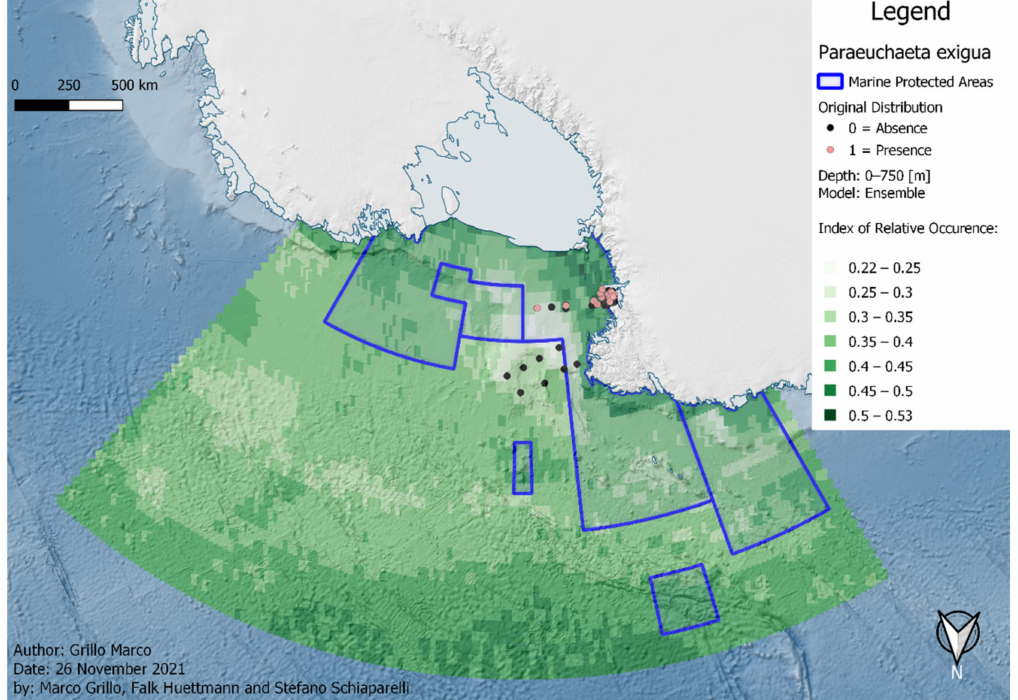
Figure 4. Presence/absence points of raw survey location shown over a predicted lattice grid distribution using the Ensemble algorithm for the depth class 0–750 m of the copepod Paraeuchaeta exigua (Wolfenden, 1911). For details, see